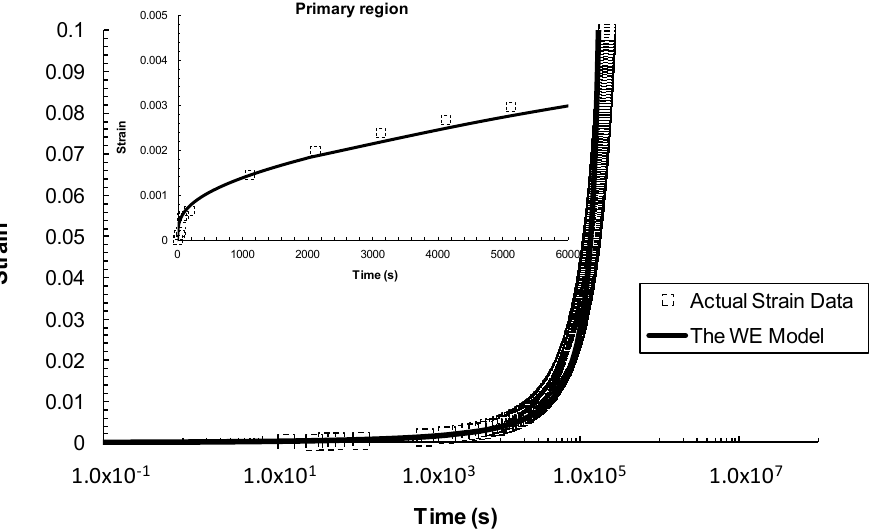
Figure 16. Creep curve for 923 K, 260 MPa predicted using the Wilshire